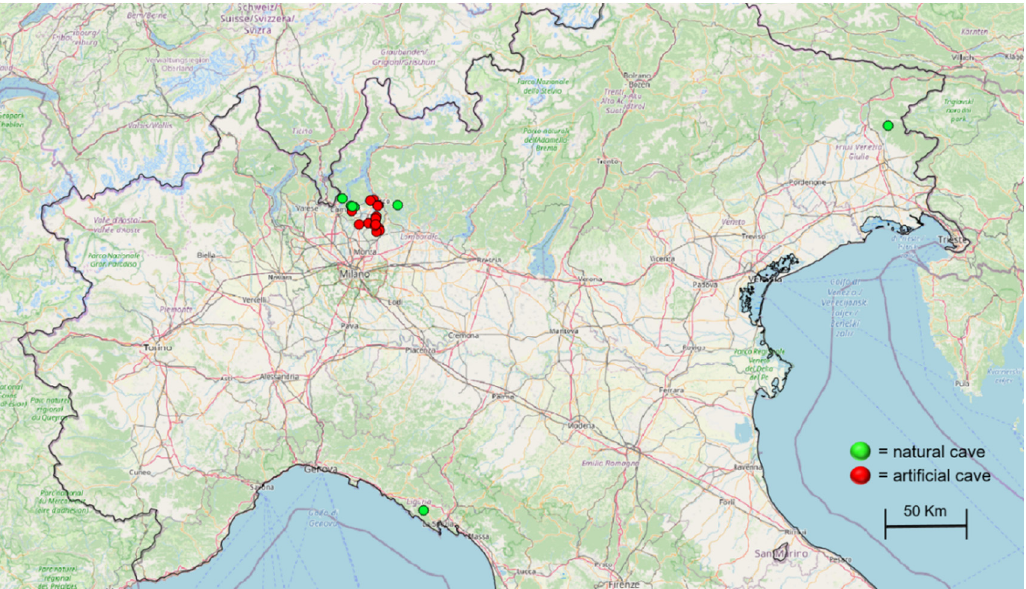
Figure 1. Sampling caves considered in this study. Caves are divided into natural (green dots) and artificial (red dots). Due to geographic proximity most of the sites are superimposed.